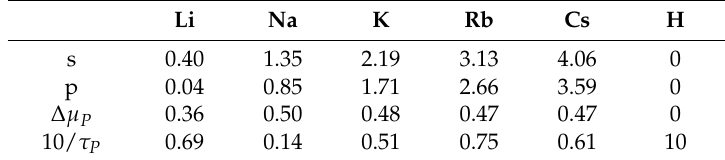
Table 1. Qantum defect µ l for s-, p-series [32] along with ∆ µ P and the factor 1/ τ P from Equation (1). Li Na K Rb Cs H s 0.40 1.35 2.19 3.13 4.06 0 p 0.04 0.85 1.71 2.66 3.59 0 ∆ µ P 0.36 0.50 0.48 0.47 0.47 0 10/ τ P 0.69 0.14 0.51 0.75 0.61